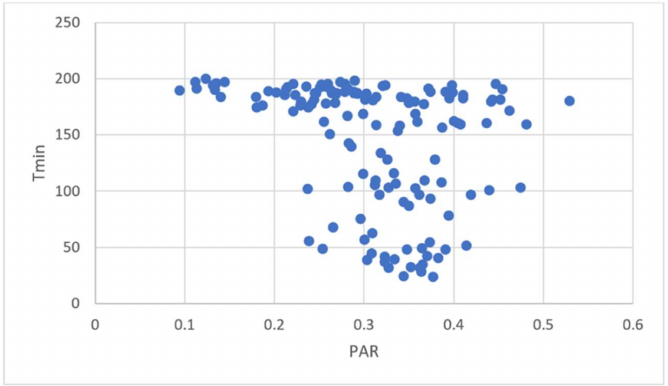
Figure 3. Determination of the parameter pitch adjusting rate (PAR), where the accepted value is